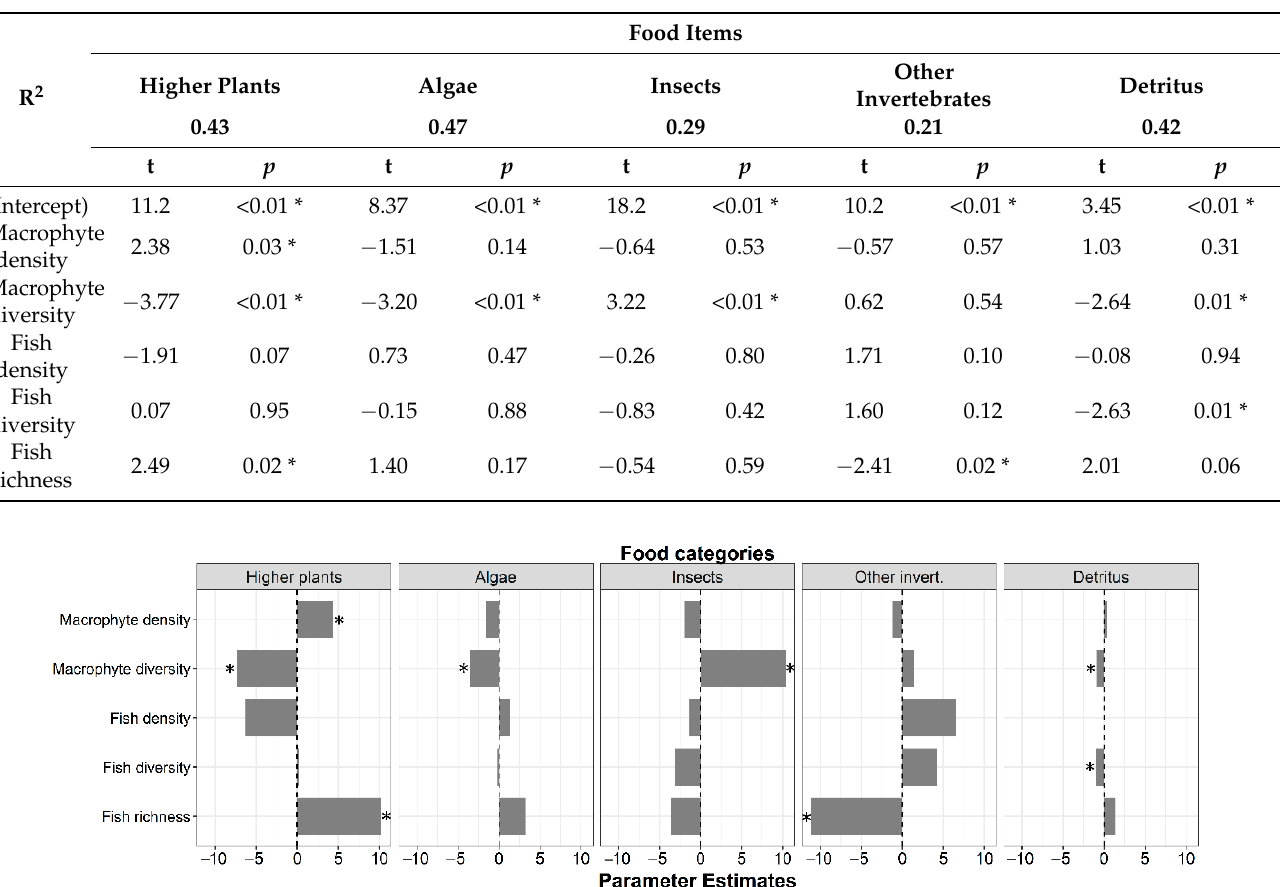
Table 2. Results of generalized linear models for the consumption of five food categories. * = statis- tically significant values.